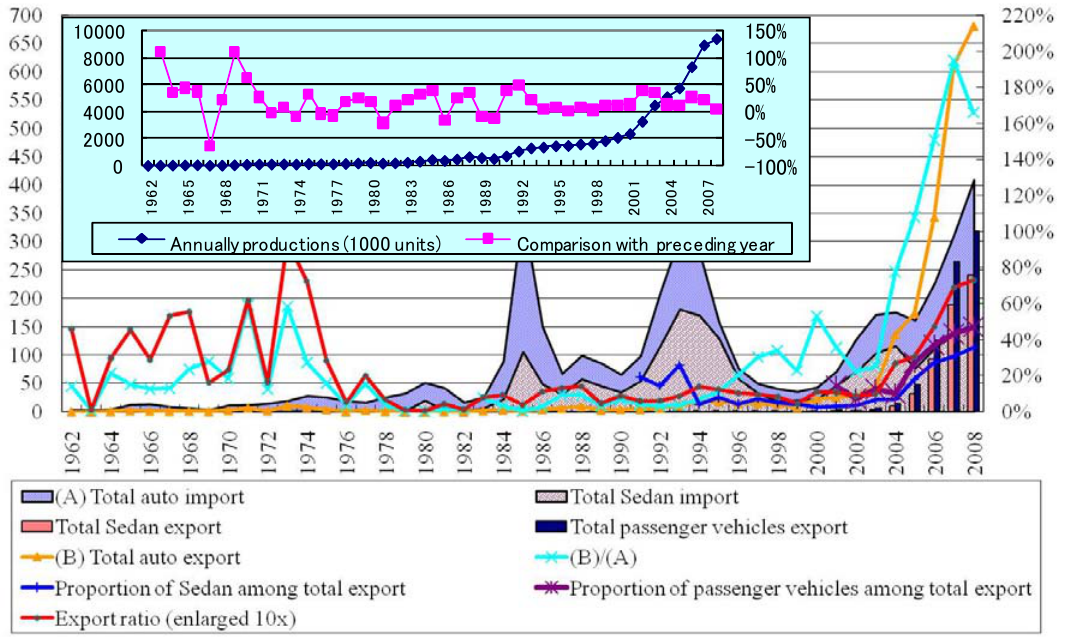
Figure 1. China’s auto production and export (1000